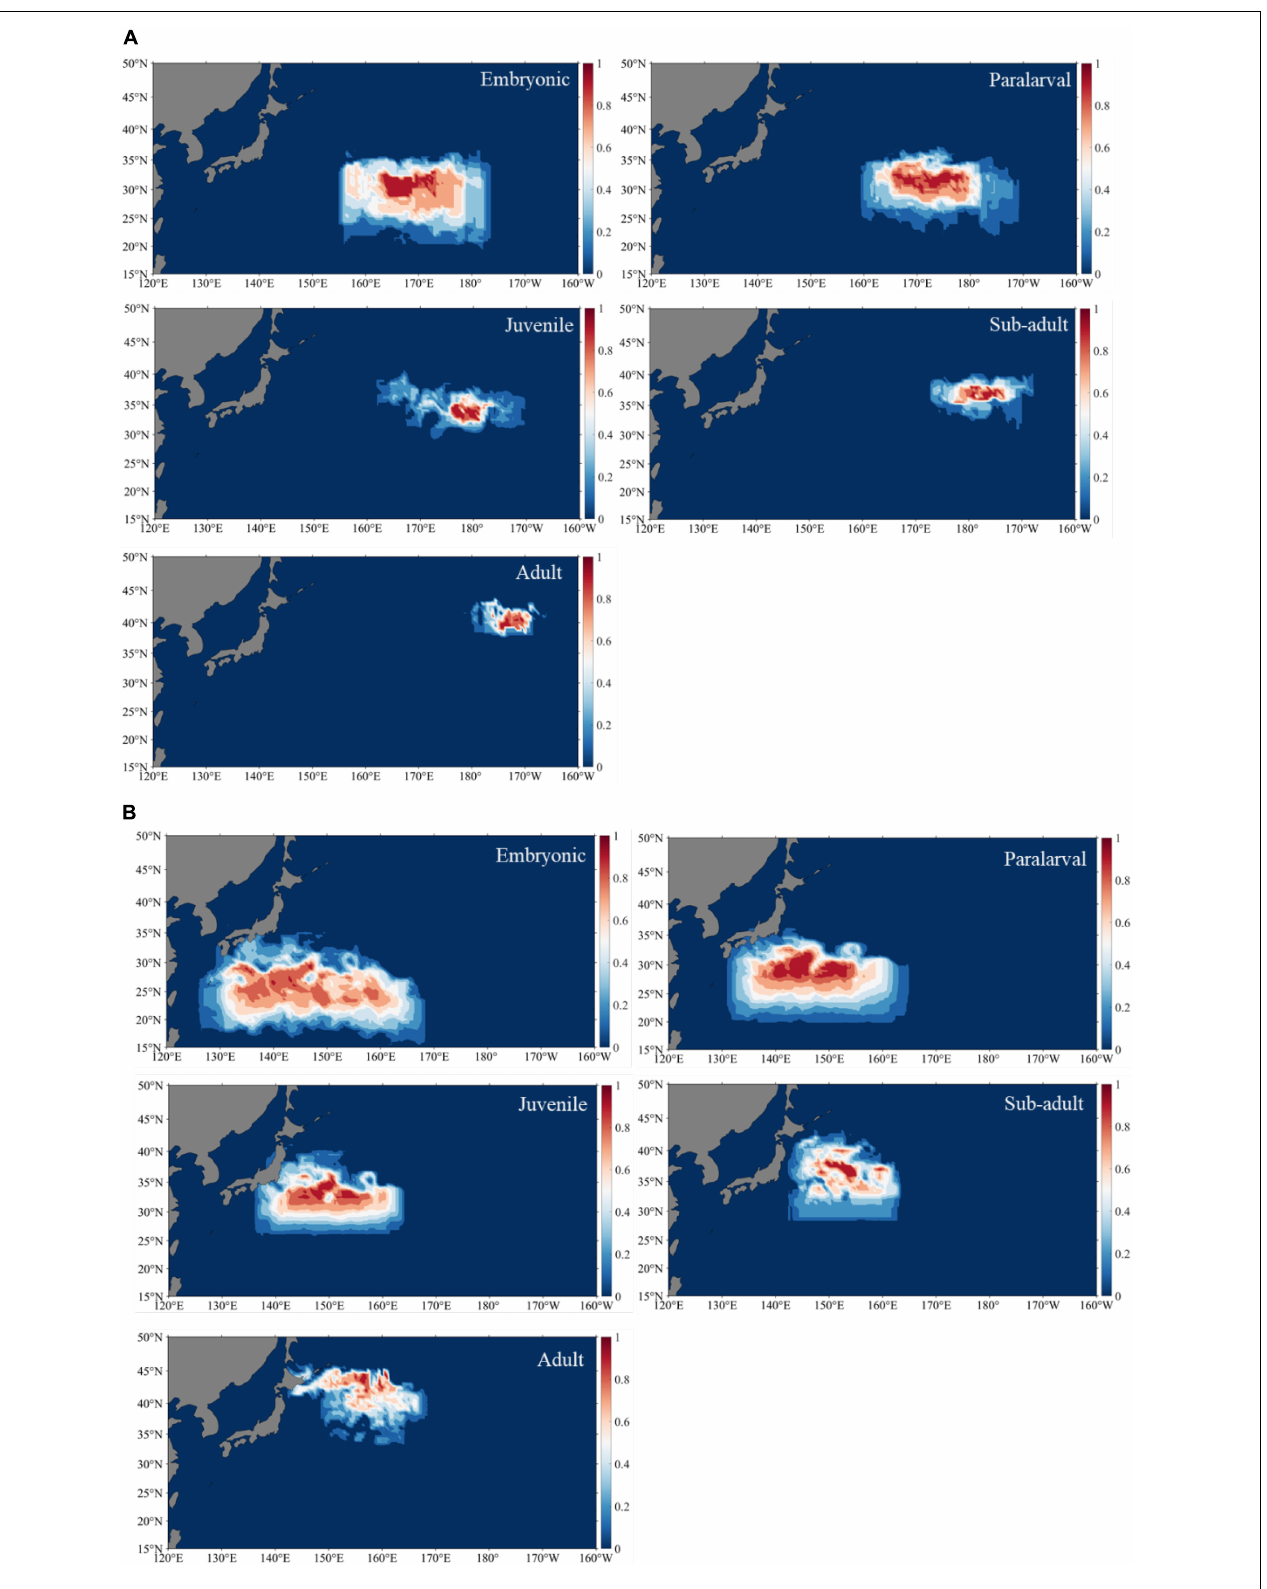
FIGURE 7 | Occurrence probability area of autumn cohort (A) and winter-spring cohort (B) of Ommastrephes bartramii at different ontogenetic stages.